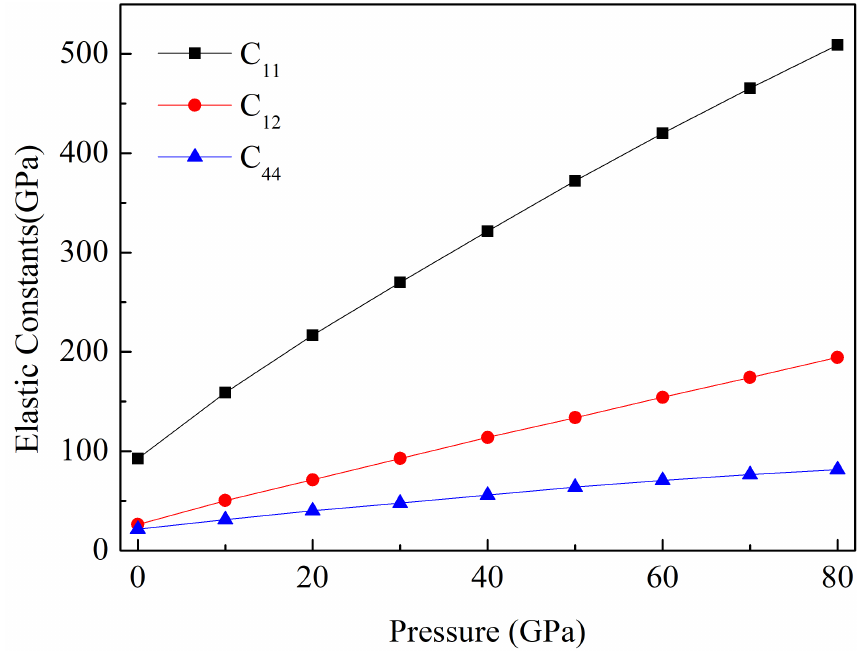
Figure 4. The elastic constants versus pressure for the β -Mg 17 Al 12